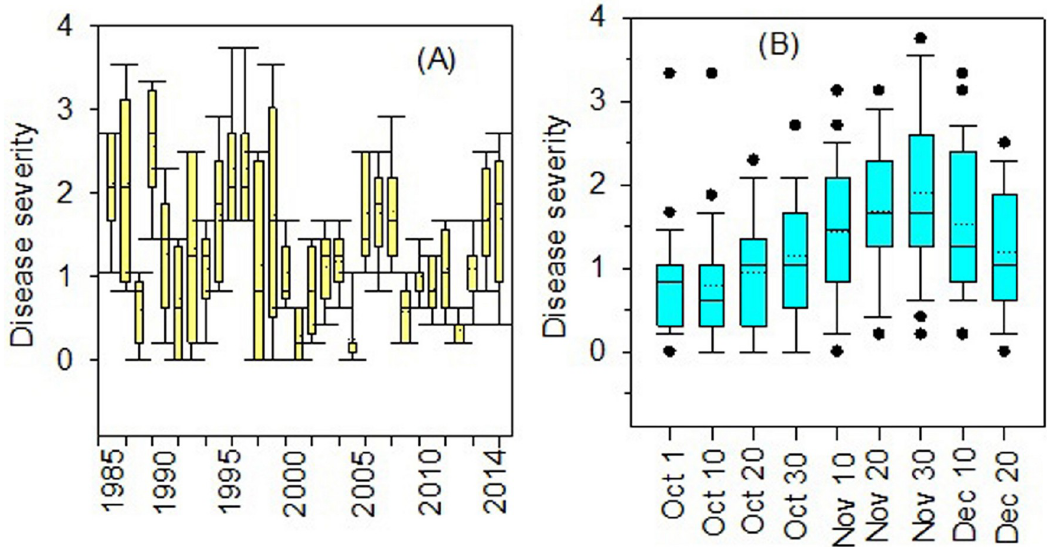
Fig 2. Stemphylium blight simulations with the stempedia model with 30 years of historical weather data: A) severity across years, B) severity across years as a function of planting time.